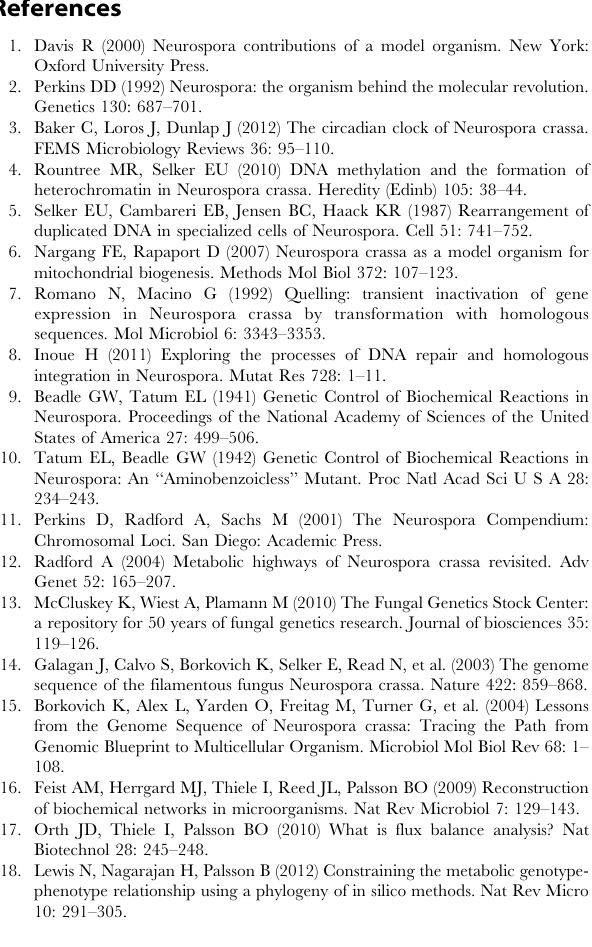
Table S1 Describes our evidence source for our growth/no- growth annotation of mutants, nutrient rescues, and synthetic lethals. Table S2 Comprehensive set of our predicted essential genes, supplemental rescues, and synthetic lethal gene pairs. Text S1 Describes the 19 inconsistencies between the test set of non-essential genes and the essential gene predictions. Text S2 Compares the steps we completed to reconstruct this model to those in the Palsson lab’s 96 step protocol